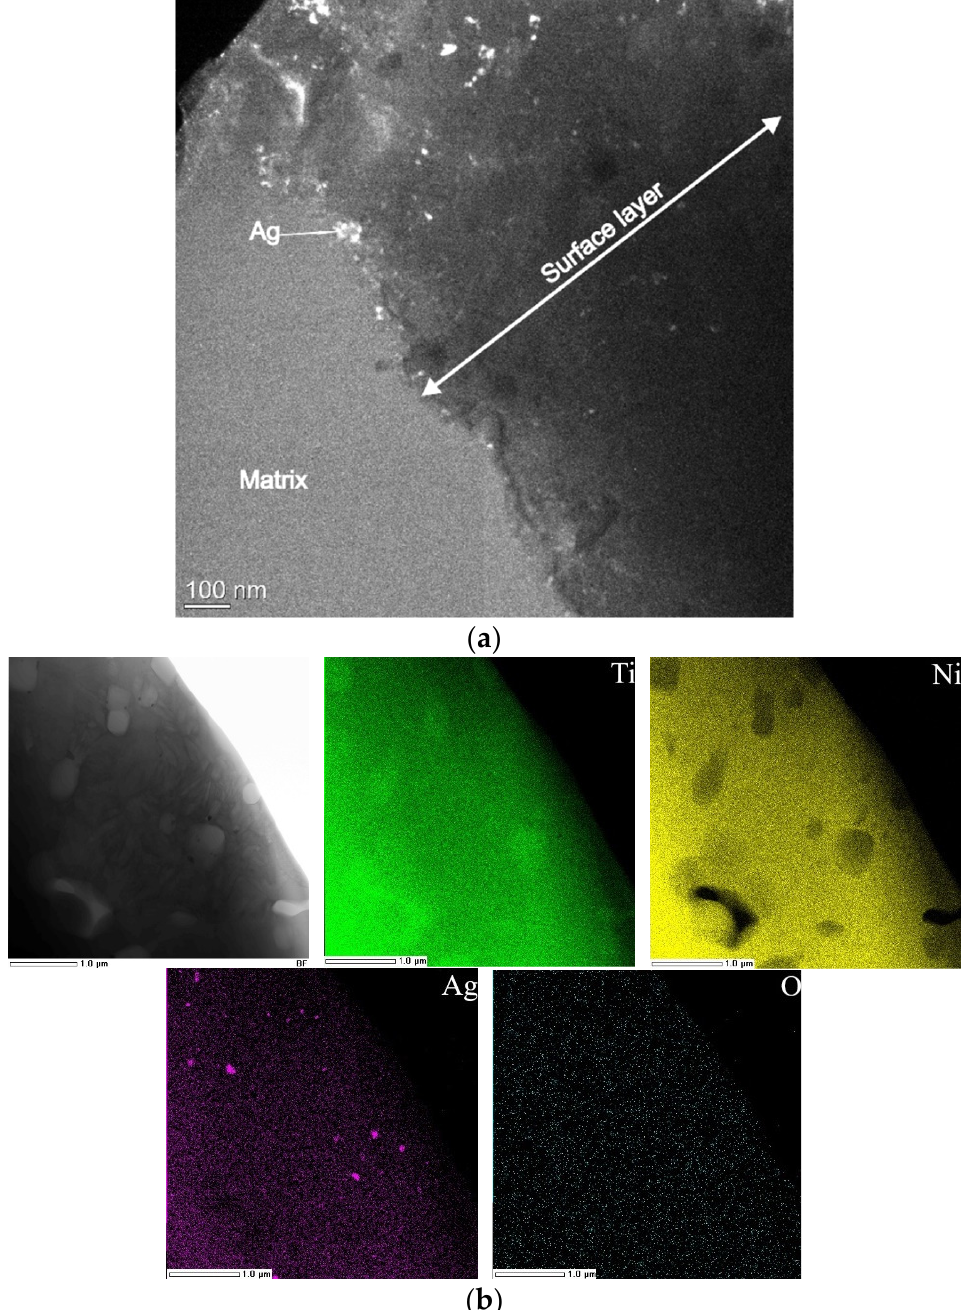
Figure 9. TEM image of TiNiAg sample in the cross-section geometry ( a ); TEM–EDS elemental mapping of TiNiAg matrix ( b ).